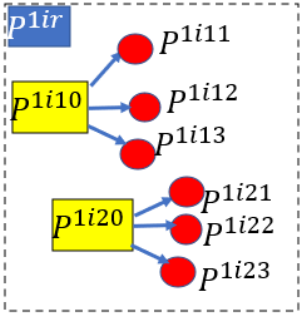
Figure 2. Typical problem structure of a single base scenario SSCED.